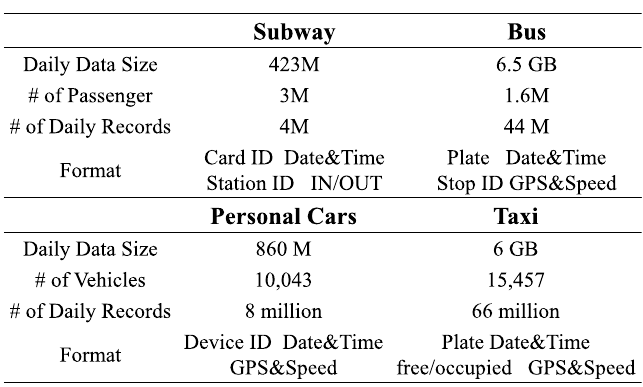
Figure 13. Mobility dataset.